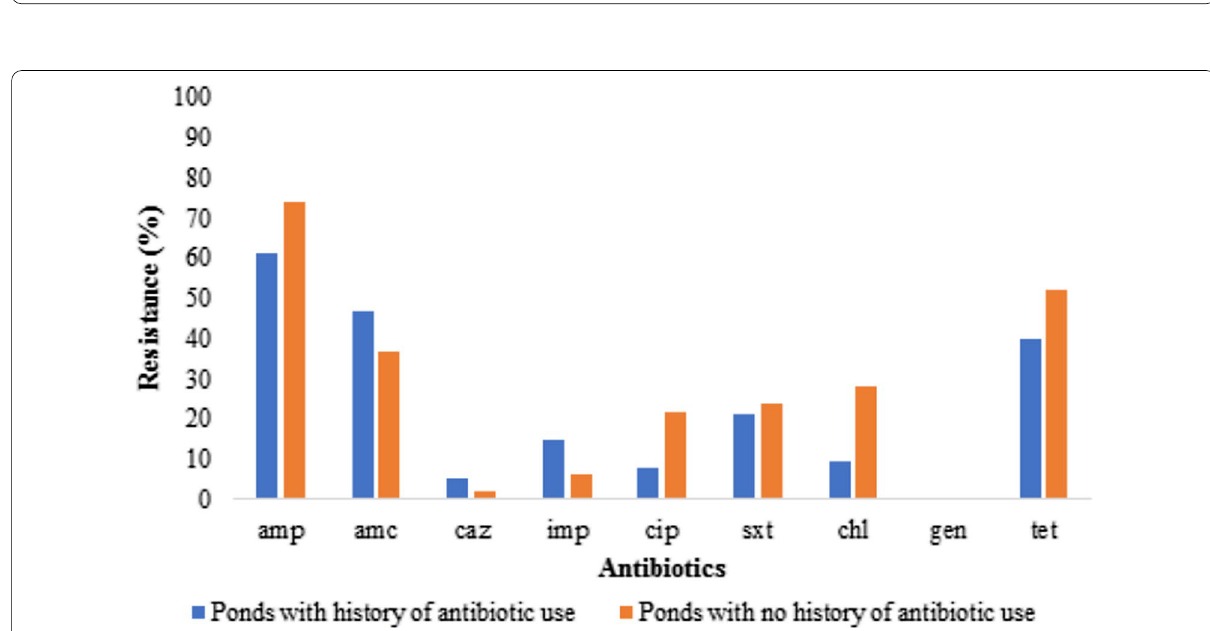
Fig. 3 Resistance of Vibrio spp. from ponds with and without history of antibiotic usage to selected antibiotics. KEY: amp: ampicillin; amc: amoxicillin-clavulanate; caz: ceftazidime; imp: imipenem; cip: ciprofloxacin; sxt: trimethoprim-sulfamethoxazole; chl: chloramphenicol; gen: gentamicin; tet: